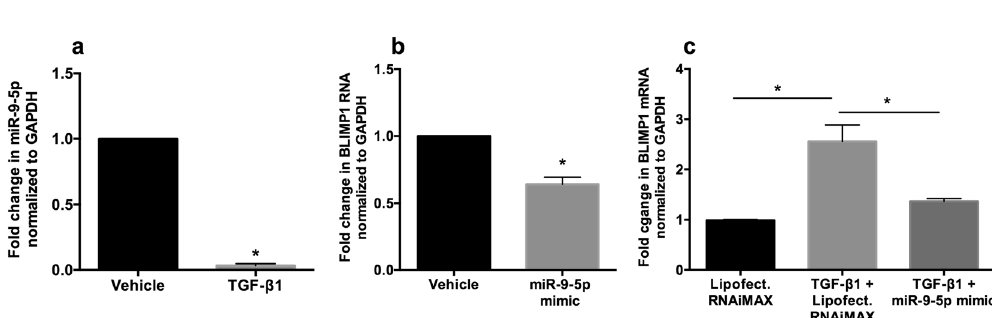
Figure 5. TGF- β 1 upregulates BLIMP-1 by suppressing miR-9-5p. NHBE ALI cultures were treated with recombinant TGF- β 1 (or vehicle as control). ( a ) TGF- β 1 completely abolishes miR-9-5p expression in NHBE ALI cultures compared vehicle treated control. n = NHBE ALI cultures from three different lungs. ( b ) BEAS-2B airway epithelial cells were transfected with miR-9-5p mimic (20 nM) using lipofectamine RNAiMAX according to manufacturer’s instructions. 48 hours post-transfection, total RNA was isolated and quantitated for BLIMP-1 expression. The miR-9-5p mimic suppress BLIMP-1 mRNA compared to lipofectamine RNAiMAX alone treated cells. n = 3 different experiments using BEAS-2B cells. ( c ) BEAS-2B airway epithelial were transfected with miR-9-5p mimic (20 nM) using lipofectamine RNAiMAX (or lipofectamine RNAiMAX as control). 24 hours following transfection, cells were treated with recombinant TGF- β 1. 16 hours following TGF- β 1 treatment, total RNA was isolated and quantitated for BLIMP-1 expression. The TGF- β 1 increases BLIMP-1 expression and this increase is reversed in cells transfected with miR-9-5p mimic. n = 3 different experiments using BEAS2B cells. * significant (p <